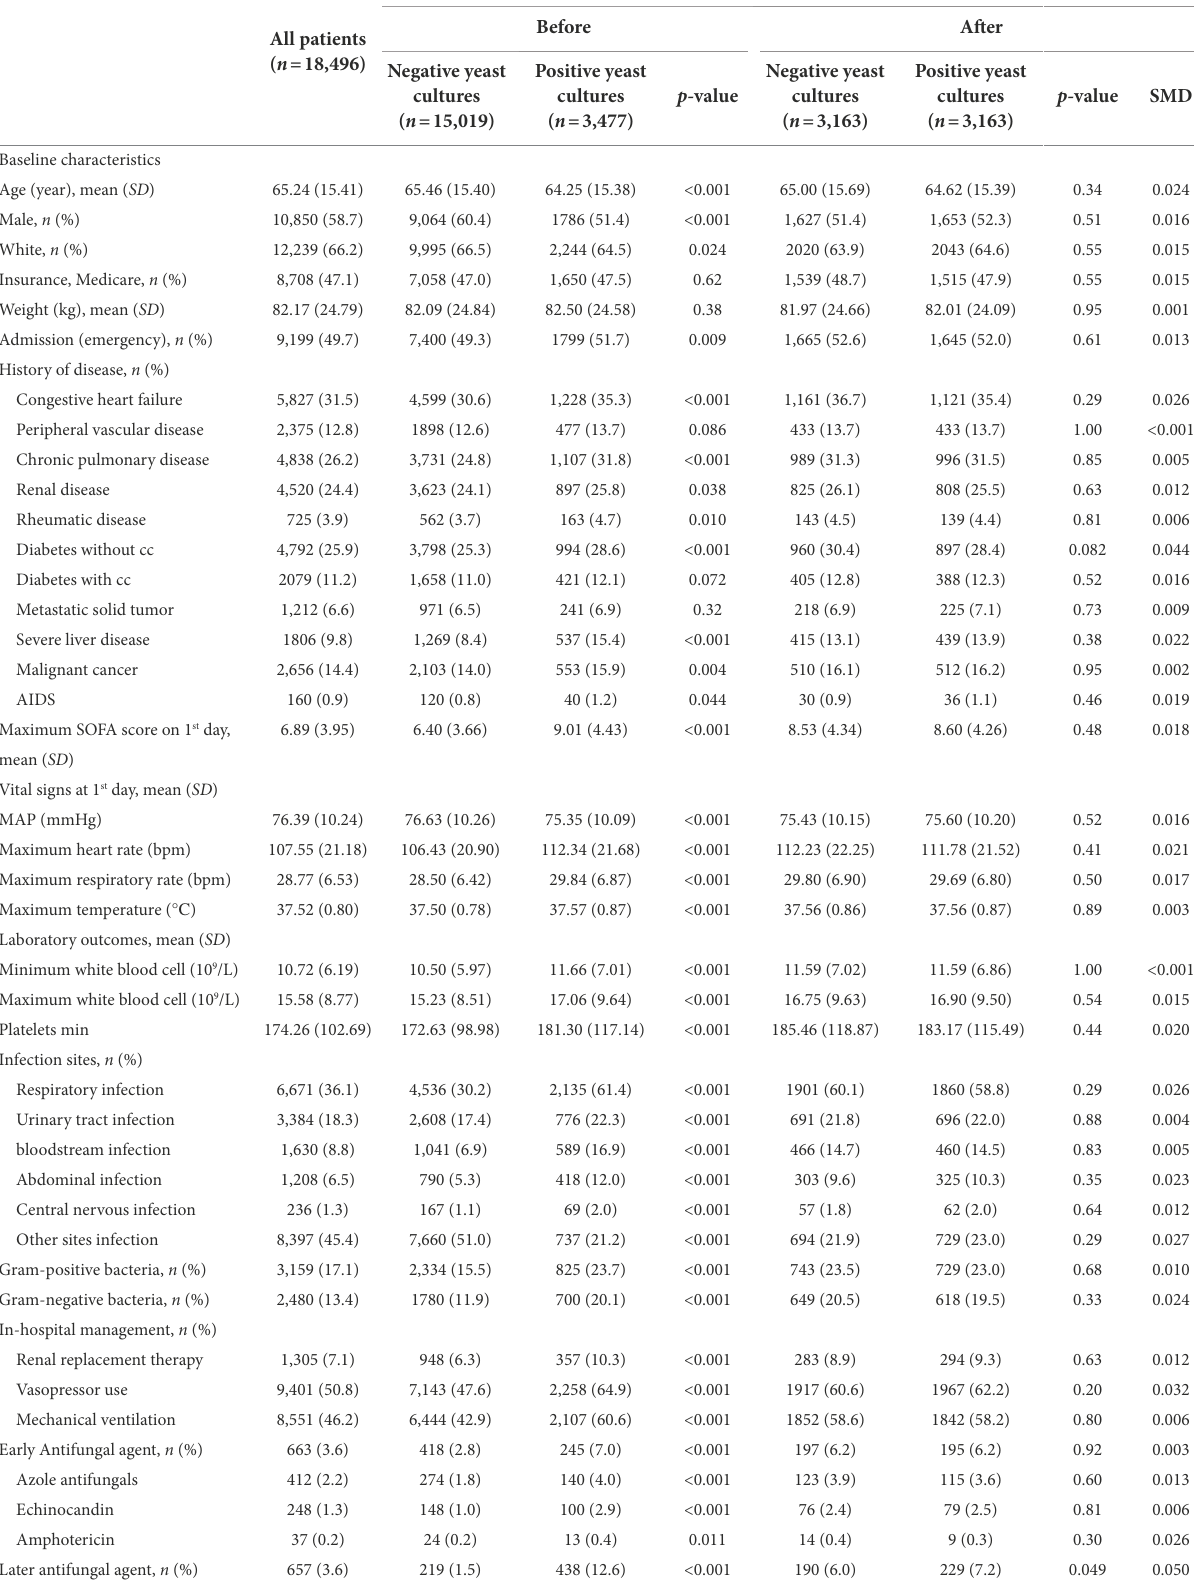
TABLE 1 Baseline demographics and clinical characteristics of the patients with negative yeast cultures and positive yeast cultures.